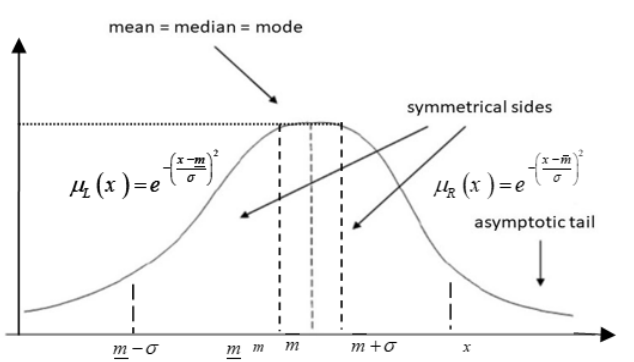
Fig. 2. L-R Gaussian fuzzy number with a